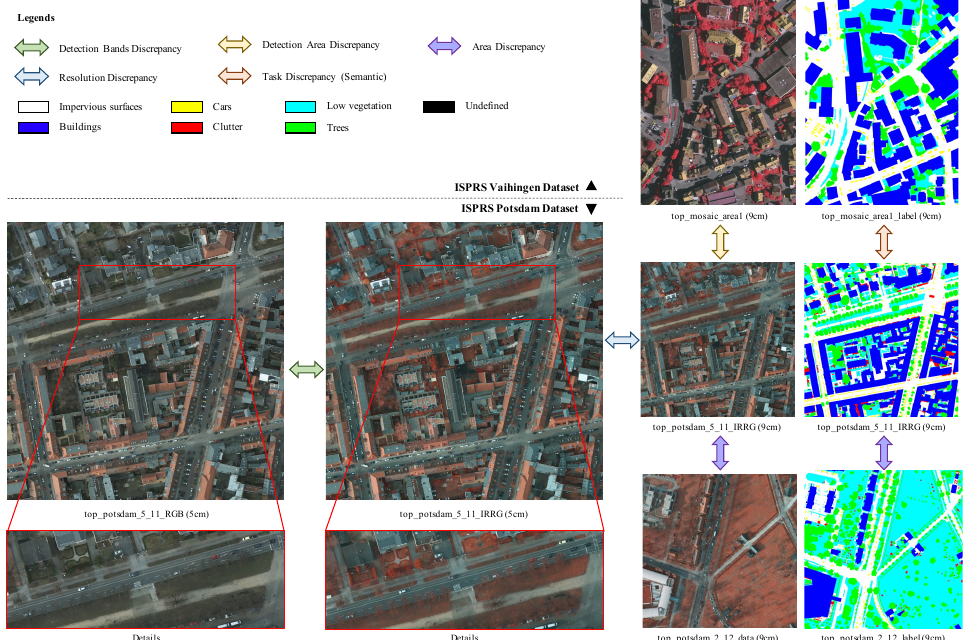
Figure 3. Some samples of an unsupervised domain shift based on the ISPRS Vaihingen and Potsdam dataset. Arrows denote differentiating factors between images and rectangles denote different semantic categories in label